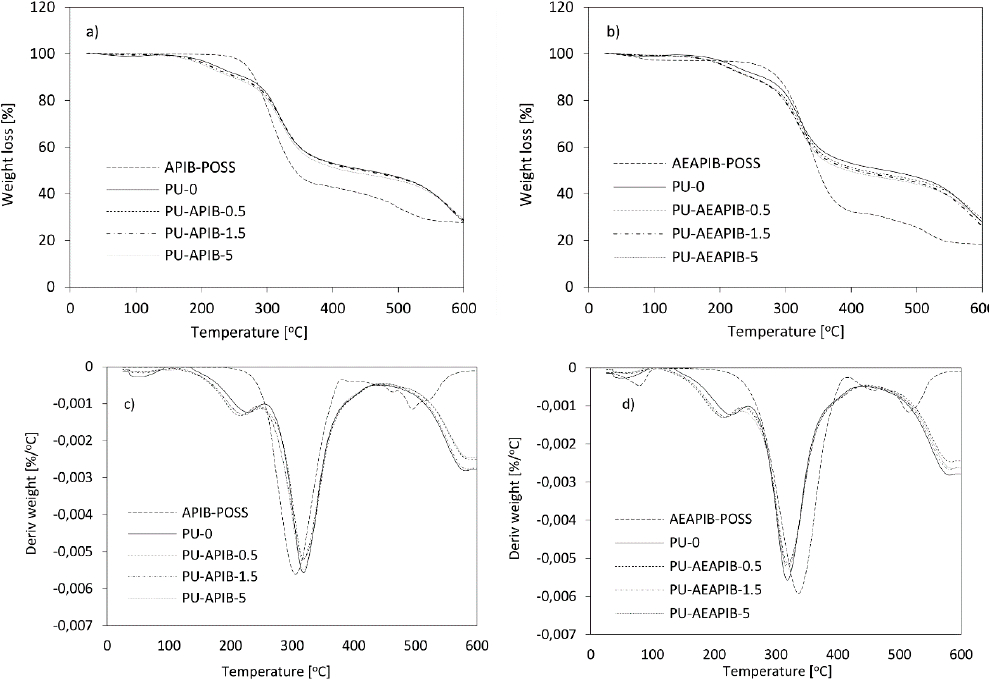
Figure 12. TGA curves for RPUFs modified with ( a ) APIB-POSS, ( b ) AEAPIB-POSS and DTG curves for RPUFs modified with ( c ) APIB-POSS and ( d ) AEAPIB-POSS.